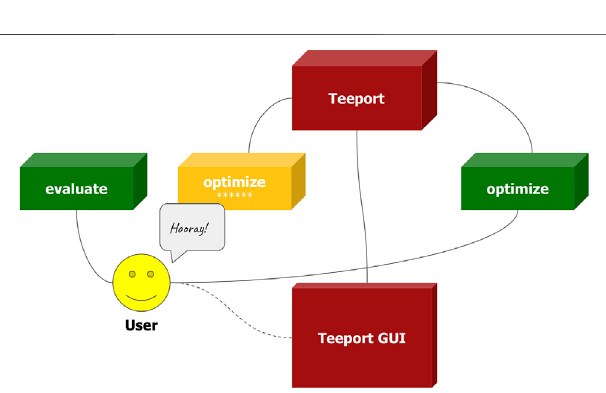
FIGURE 8 | Using Teeport to monitor the optimization process without writing visualization-related code. The user in this cartoon used the use_optimizer (optimize) API upon the optimize function (green cube) to get a Teeportized optimize function (yellow cube). An alternative way to achieve the same goal is to wrap the evaluate